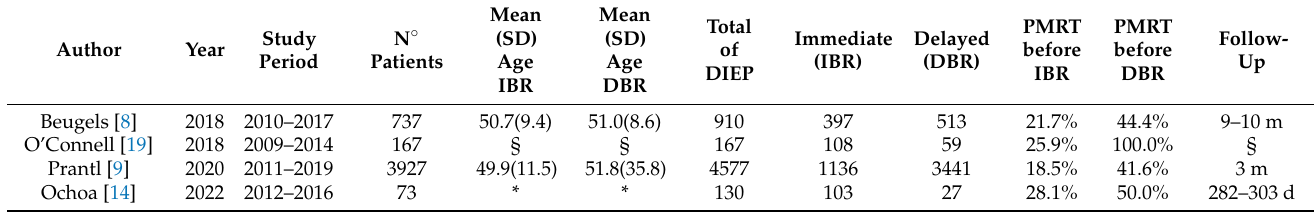
Table 2. Characteristics of the included studies.